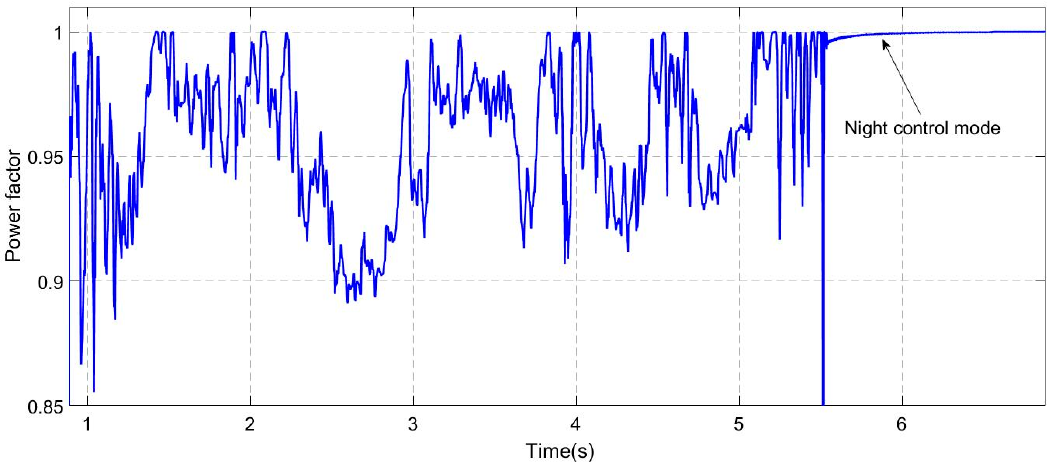
Figure 20. Waveform of power factor at load.